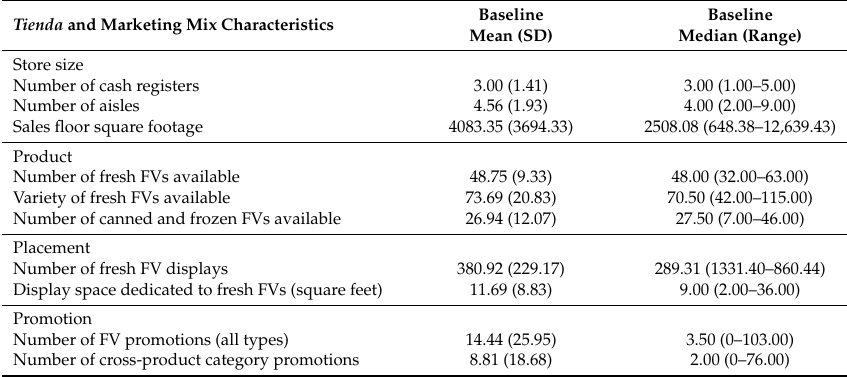
Table 2. “ El Valor de Nuestra Salud ” (The value of our health) baseline tienda and marketing mix characteristics ( n =